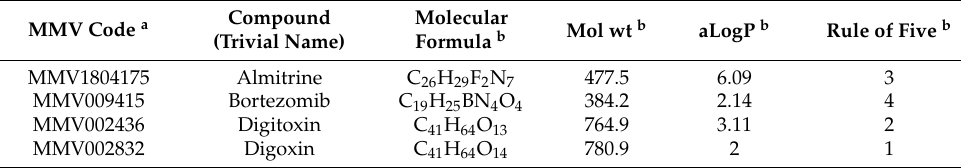
Table 1. General characteristics of the 13 compounds tested against T gondii in